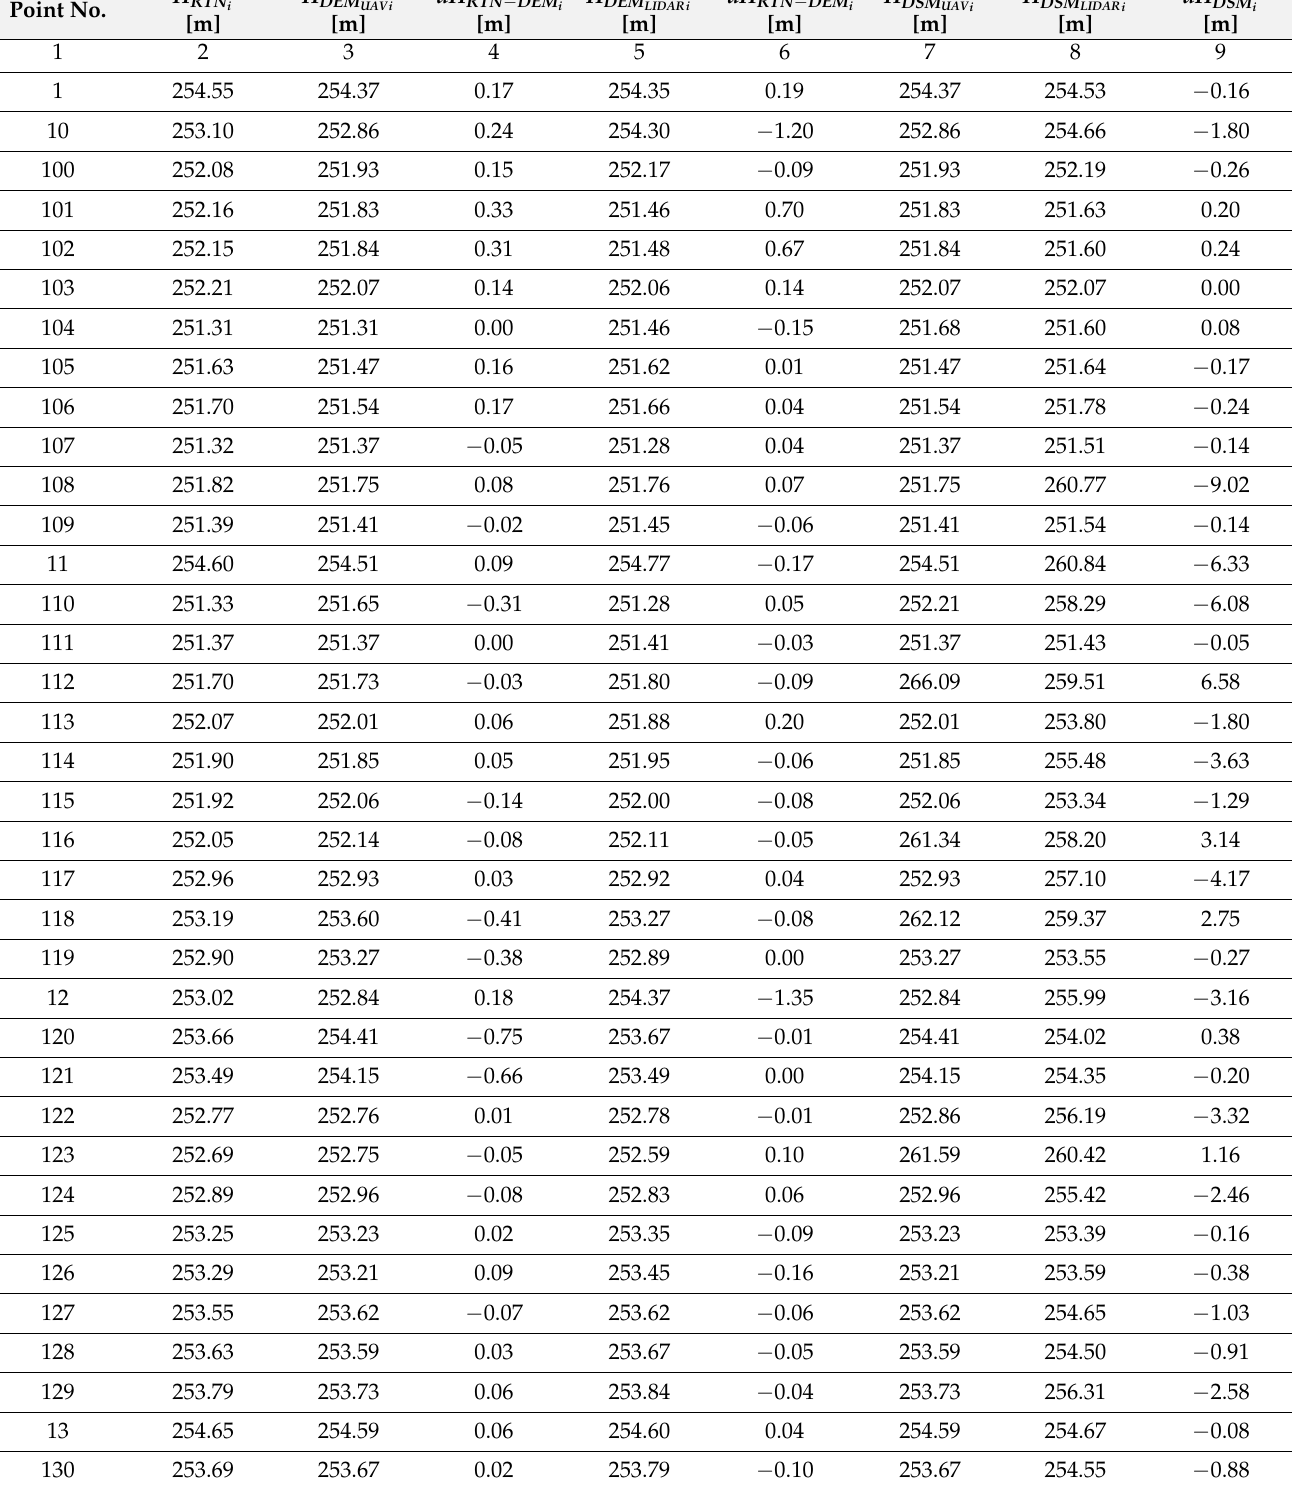
Table A1. Comparison of point heights measured in the field using the RTN technique with point heights read from the DEM and DSM created from the LIDAR and UAV point clouds; source: own